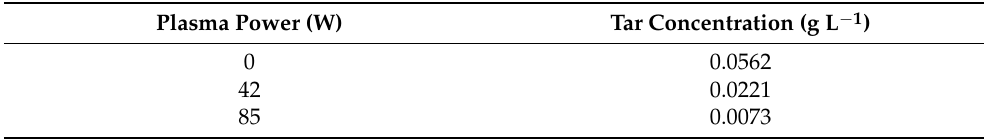
Table 2. The effect of plasma on tar